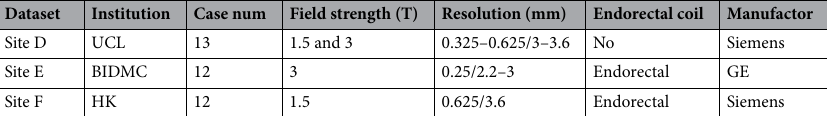
Table 1. The details of sample number and imaging protocols in the multi-site MRI